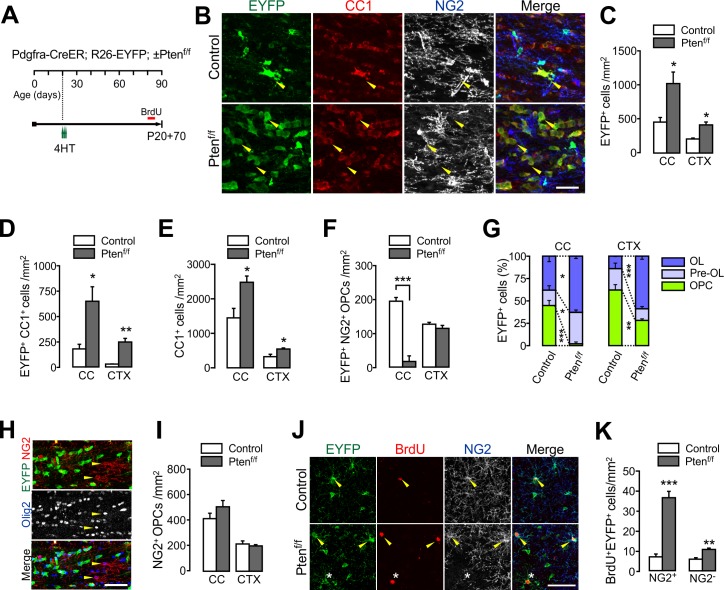
PTEN-deficient OPCs continuously add new oligodendrocytes.(A) Experimental scheme for 4HT and BrdU administration into Pdgfra-CreER; R26-EYFP; ±Ptenf/f mice, and for mouse sampling at P90 (P20 +70). (B) Confocal images of EYFP+ cells in the CC showing their maturation stage. Arrowheads indicate EYFP+CC1+ OLs. Scale bar, 50 µm. (C) Number of EYFP+ cells in the CC and CTX at P20 +70. (D) Number of EYFP+CC1+ OLs. (E) Number of total CC1+ OLs. (F) Number of EYFP+NG2+ OPCs. (G) Percentages of OPC, pre-OL and OL among EYFP-labeled cells in the control and Pten cKO mice at P20 +70. (H) Confocal images of NG2+ OPCs in the CC of Pten cKO mice. At P20 +70, resident Olig2+NG2+ OPCs did not EYFP+ OPCs (arrowheads) in the CC. Scale bar, 50 µm. (I) The number of total NG2+ OPCs did not change in Pten cKO mice. (J) Confocal images of cortical EYFP-labeled BrdU+ cells. Arrowheads and asterisk indicate BrdU+NG2+ OPCs and a BrdU+NG2- cell, respectively. (K) Number of BrdU+EYFP+NG2+ OPCs and BrdU+EYFP+NG2- OL lineage cells in the CTX. Data are represented as mean ±S.E.M. n = 3 (control) and 4 (Pten cKO) mice. *p<0.05; **p<0.01; ***p<0.001. Unpaired Student's t-test. The numerical data for the graphs are available in Figure 3—source data 1.10.7554/eLife.32021.014Figure 3—source data 1.Numerical data for graphs in Figure 3.